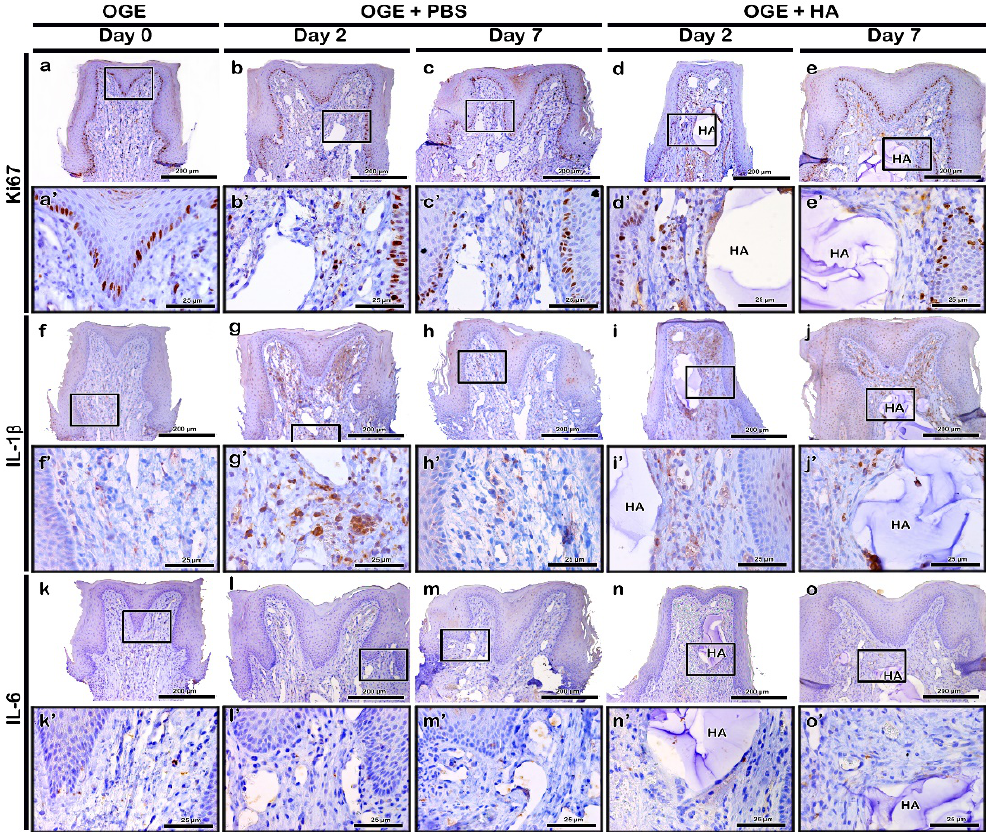
Figure 4. Immunolocalization of Ki67, interleukin (IL) - 1β, and IL -6 in interdental papilla (IDP) after phosphate buffer saline (PBS) or hyaluronic acid (HA) filler injection. Localization patterns of Ki67 ( a – e ), IL- 1β ( f – j ), and IL-6 ( k – o ) in IDP on days 2 and 7 post-PBS ( b , c , g , h , l , m ) or -HA filler ( d , e , i , j , n , o ) injection. Higher magnification view of box in a–o ( a ’– o ’). HA, hyaluronic acid. Scale bars: 200 μm ( a – o ) and 25 μm ( a ’– o ’).